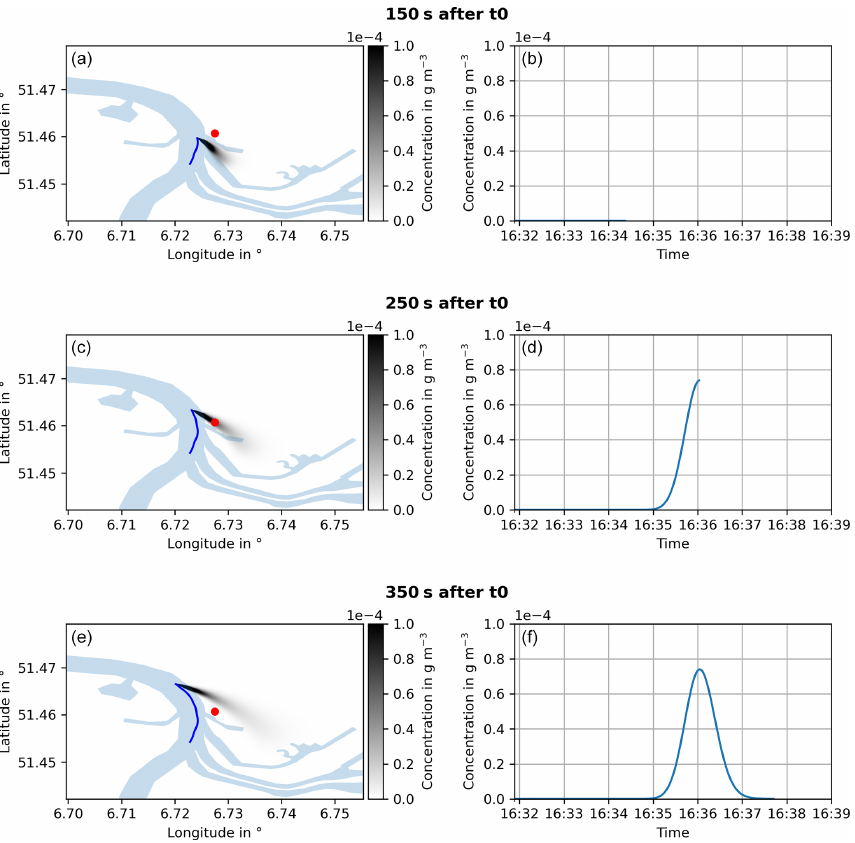
Figure 3. Example of a plume simulation for different time steps after the simulation start (t0). The upper, middle, and lower panels show the movement of the modelled ship plume 150, 250, and 350s after the initiation of the plume. (a, c, e) A horizontal cross section of the modelled plume with 20m height. The location of the measurement station is marked as a red dot. The blue line in panels (a) , (c) , and (e) shows the modelled concentration at the location of the measurement station during the model